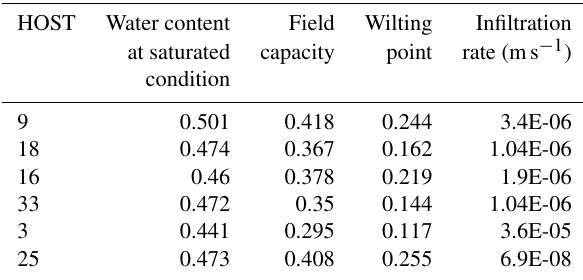
Figure 2. The comparison of model calibration with different soil settings. Table 1. Soil properties for corresponding HOST